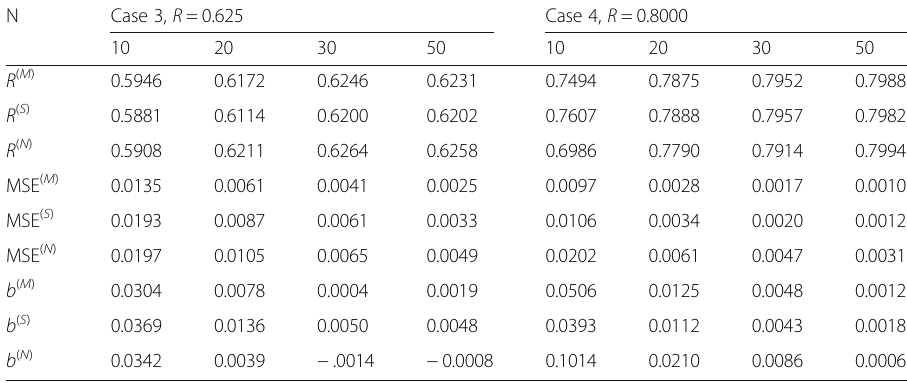
Table 3 Reliability of special cases of BIEF Case 3, R = 0.625